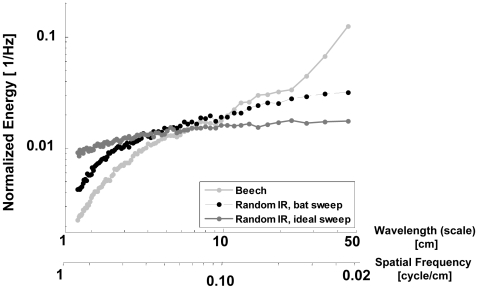
The effect of the emitter.Normalized spectra of the artificial IR-envelopes simulated with two different emitted signals aside the real spectrum of beech. Spectra were normalized to have a sum of one.